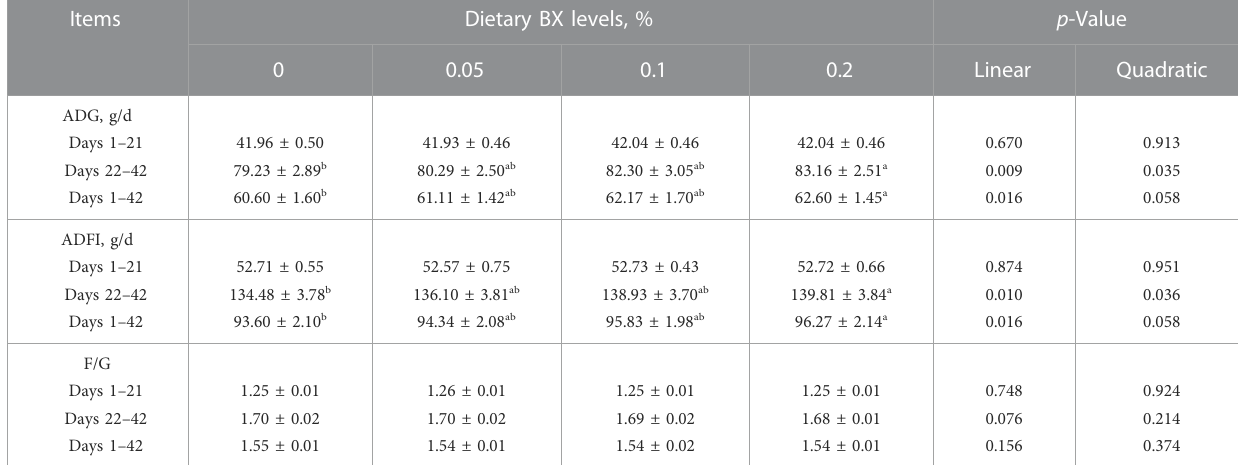
TABLE 2 Effects of dietary supplementation of Wheat germ, Hops and Grape seed extract mixture (BX) on growth performance in broilers. Items Dietary BX levels, %